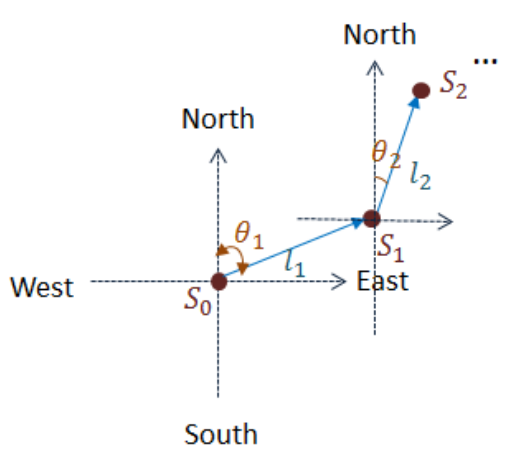
Figure 4. Step detection.